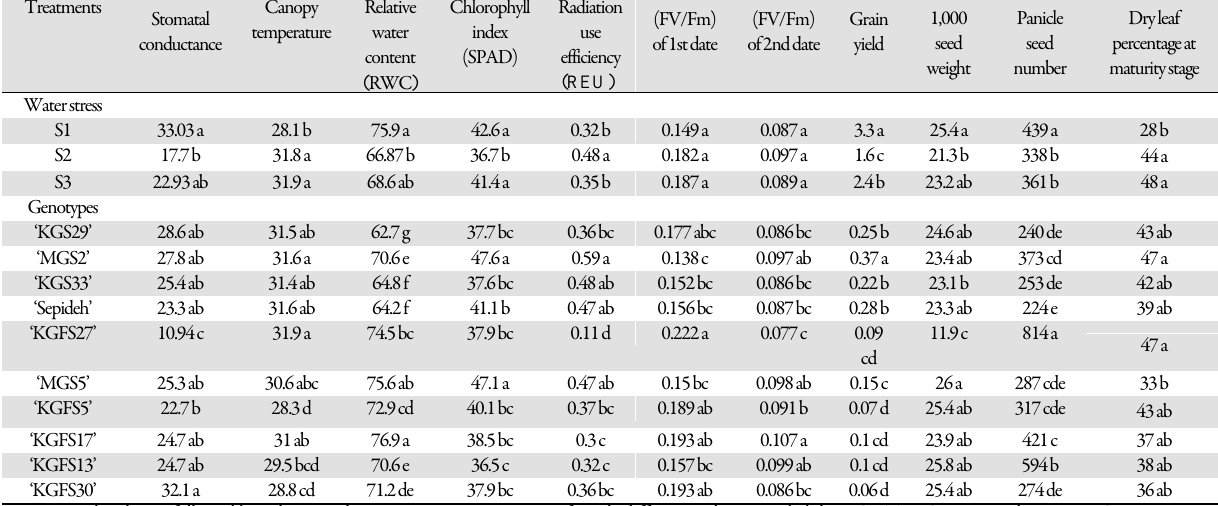
Table 2. Mean comparison of the effect of water stress on physiological traits in grain sorghum genotypes